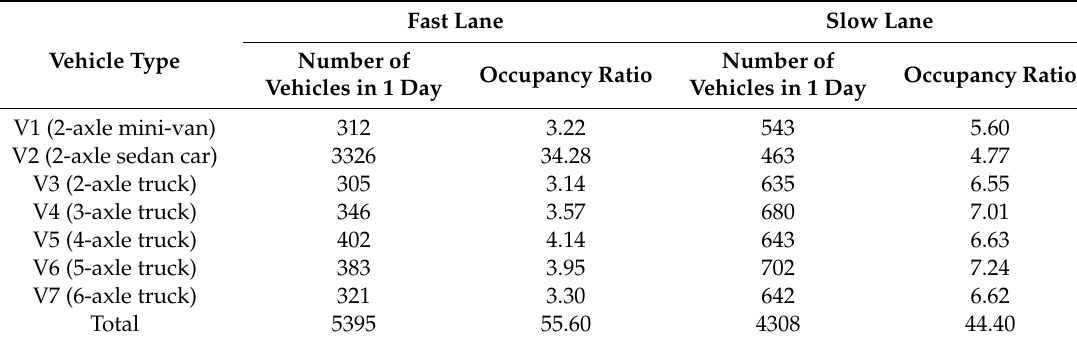
Figure 3. Hourly tra ffi c volume: ( a ) Fast lane; ( b ) slow lane. Table 3. Vehicle categories and the corresponding tra ffi c lane occupancy ratios ( × 100%).